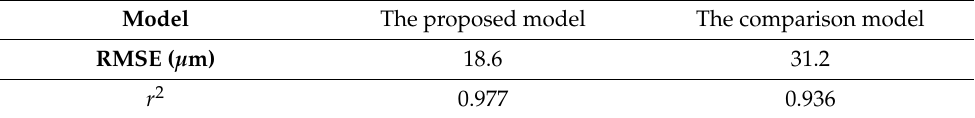
Table 7. The evaluation results of the model predictions. Model